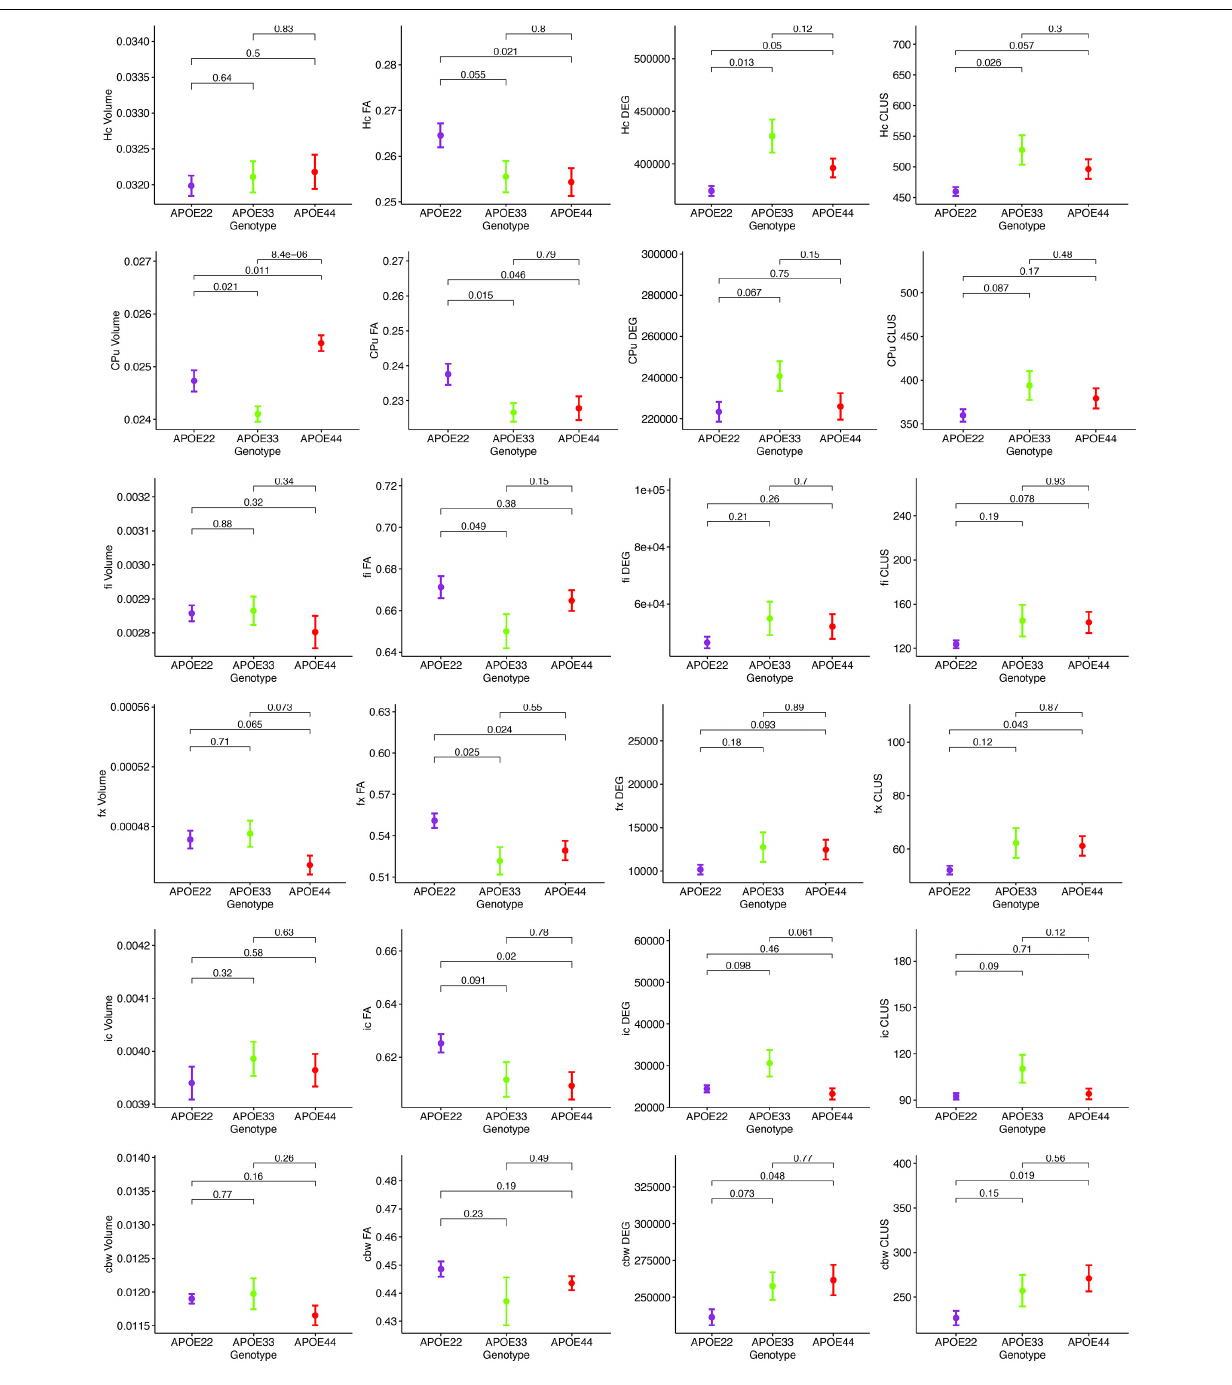
APOE3 and APOE4 mice ( t = − 4.4, p < 0.001). Differences between groups of males were only significant between APOE3 and APOE4 mice ( t = − 2.9, p = 0.02). Differences between males and females for APOE4 mice were characterized by t = 1.7, p = 0.1.